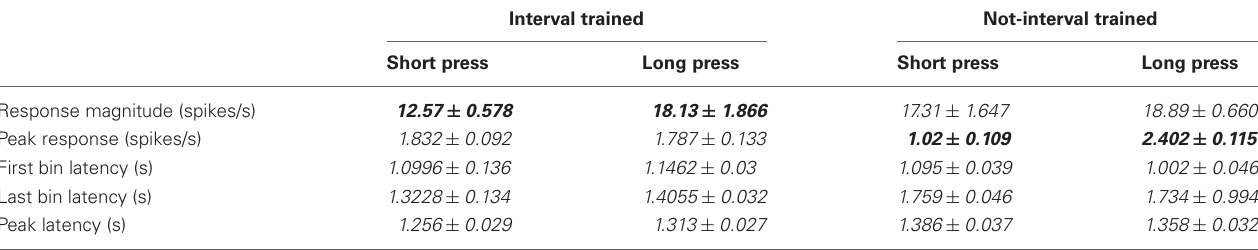
Table 2 | Comparison of neuronal response properties between the short and long press for interval trained and non-interval trained